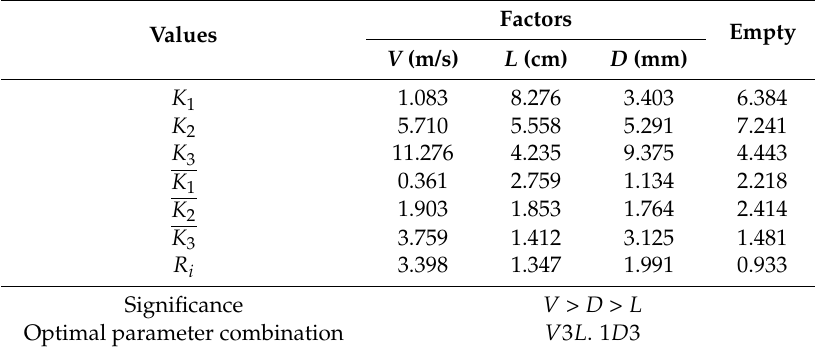
Table 5. Range analysis table of the erosion volume.